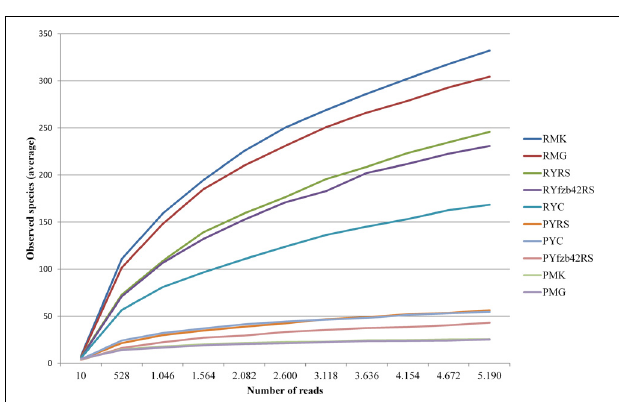
FIGURE 4 | Rarefaction analysis comparing overall diversity of the indigenous microbiota of the investigated lettuce samples (var. Tizian). Prior to rarefaction analysis, rhizosphere, and phyllosphere libraries were pairwise combined corresponding to the particular treatments. Rarefaction curves show saturation of the combined datasets that were clustered at 97% sequence similarity. The curves are supported by 95% confidence intervals. The overall diversity was higher affected in the rhizosphere. In both habitats plants treated with Rhizoctonia solani showed higher diversity than plants treated additionally with FZB42 or untreated plants. Abbreviations: P, phyllosphere; R, rhizosphere; Y, young; M, mature; RS, R. solani ; C, untreated (control); FZB42RS, FZB42 and R. solani co-inoculation; G, healthy; K,